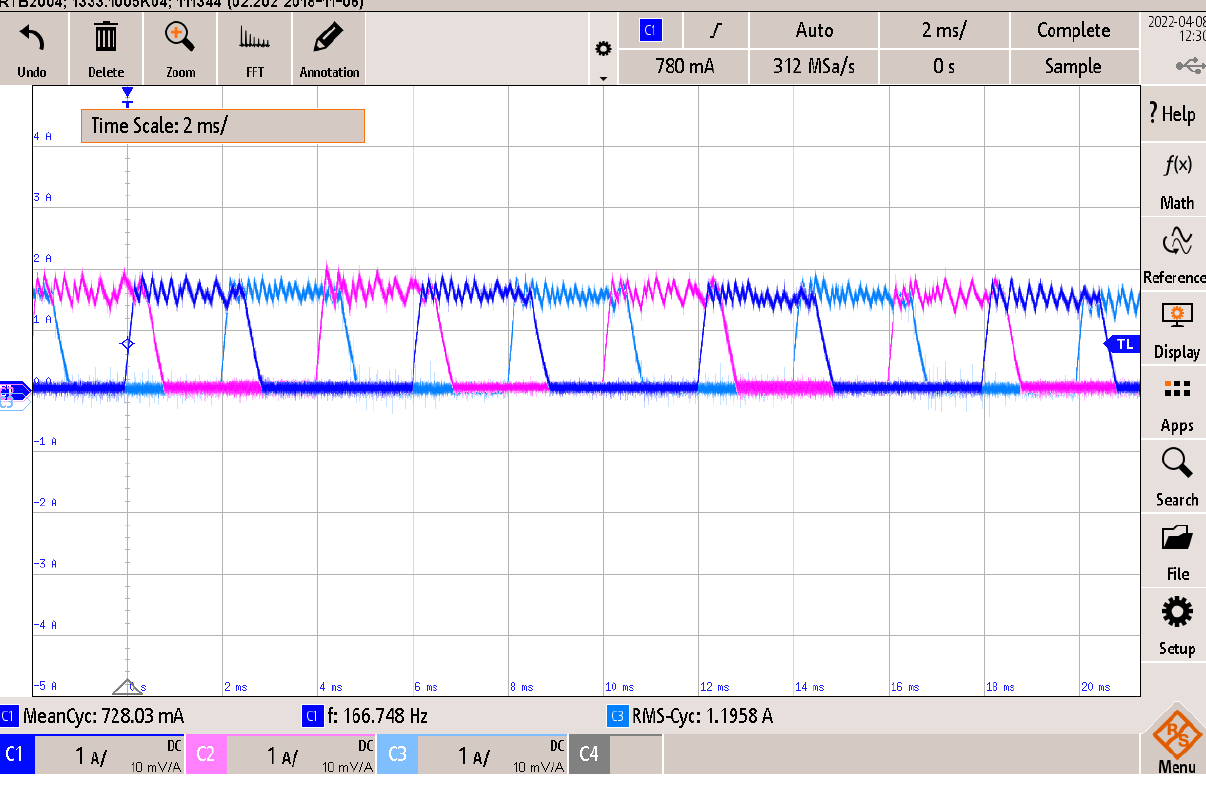
Figure 33. Phase currents of 6/10 SRM prototype in no-load operation at the speed of 1000 rpm.